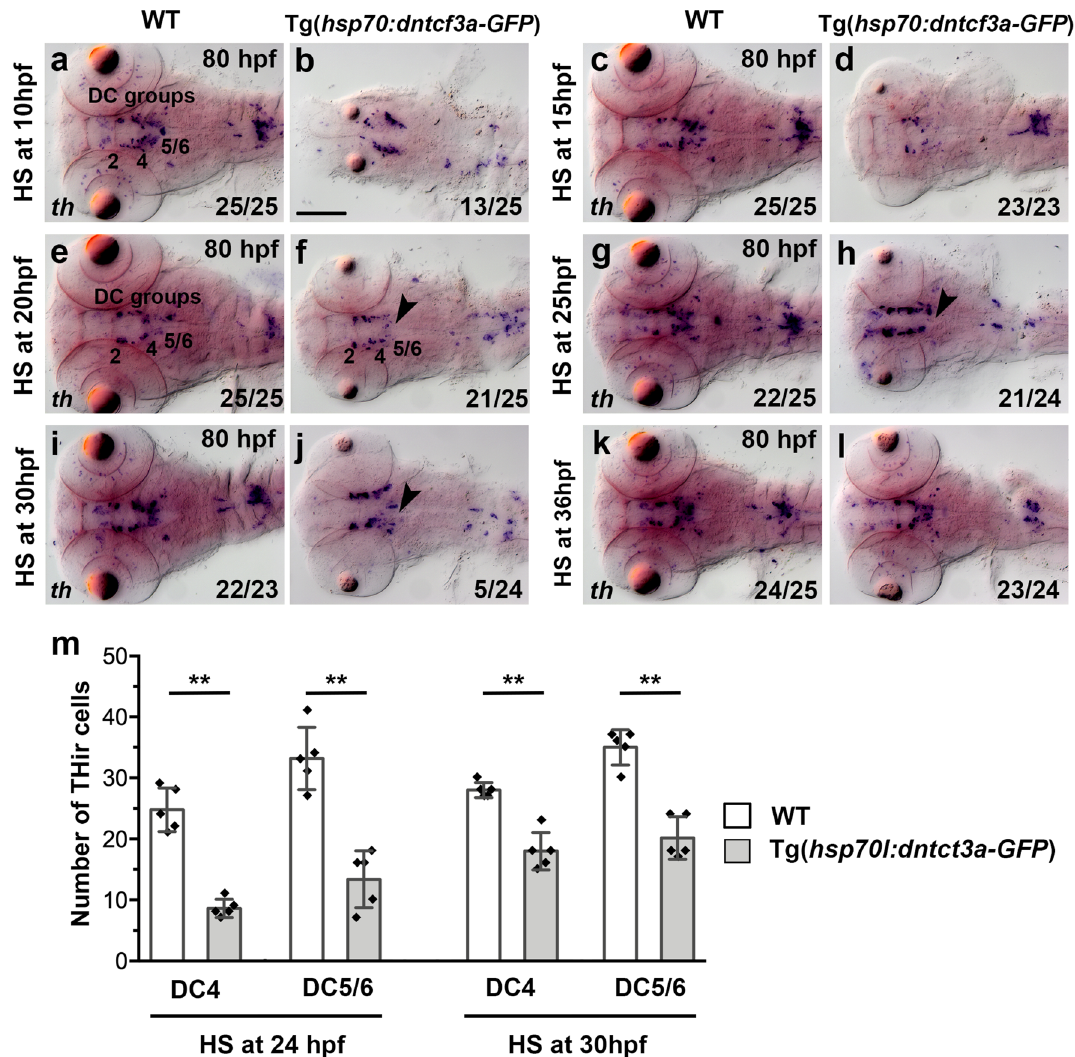
Figure 8. Heat-shock induced ΔTcf3 overexpression causes reduction in ventral diencephalic DC4 and hypothalamic DC5 and DC6 DA neurons. ( a – l ) Expression of DA neuron marker th as detected by WISH in WT embryos and in heterozygous transgenic Tg( hsp70l:Δtcf3a-gfp ) [here designated Tg( hsp70l:dntcf3-GFP )] siblings after heat-shock treatment as indicated on the left side of each pair of images, and subsequently fixed at 80 hpf. Dorsal views, images are Z-projections of image stacks. The th expressing DC groups 2–6 are indicated. The arrowheads point to a decrease in th expression in DC5 and DC6 DA neuron groups. Scale bar in ( b ) is 100 µm for all images. Numbers N/N in bottom right corner of each image indicate number of representative phenotypes as shown in image versus total embryos analyzed for this condition. ( m ) Quantification of TH-immunoreactive cells in WT embryos compared to heterozygous transgenic Tg( hsp70l:dntcf3-GFP ) siblings heat shocked as indicated fixed at 82 hpf. Bar charts show cell count numbers and the mean of TH-immunoreactive cells for each indicated DA neuron groups. Error bars depict standard deviations of the mean. Asterisks indicate significant differences compared with the non-transgenic sibling control (**p = 0.0079; Mann–Whitney U test; n = 5 in each condition. Software: Prism 6.0f. from GraphPad Software